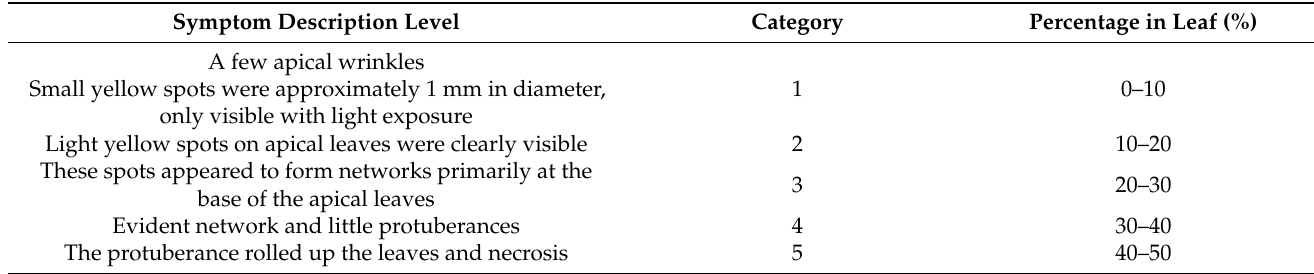
Table 1. Symptoms scale in infected plants proposed by Torres-Pacheco